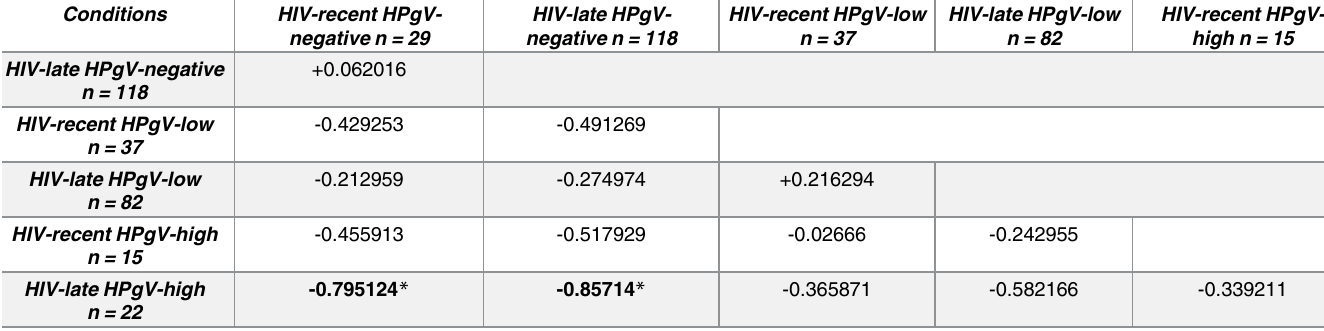
Table 2. Mean difference of HIV viral load in co-infected subjects according to time of HIV infection and HPgV viral load conditions.